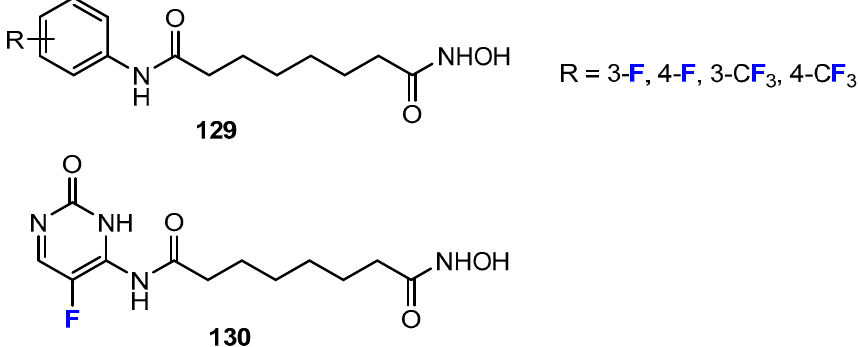
Figure 3. Chemical structures of fluorinated hydroxamic acids by Salmi-Smail et al. [68]. Zhang, Liu, Gao et al. [60,61] adduced the HDACi largazole (Figure 2) and performed